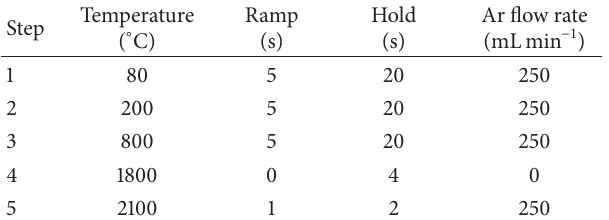
Figure 1: The effect of pH on the absorbance of the system, condi- tions: sample volume 5.0 mL containing 1.0ng mL −1 of Zn(II), dis- persive solvent 1.0mL ethanol, extraction solvent 100 𝜇 L CCl 4 con- taining 1.0 × 10 −6 molL −1 of PPT, extraction time 10min.